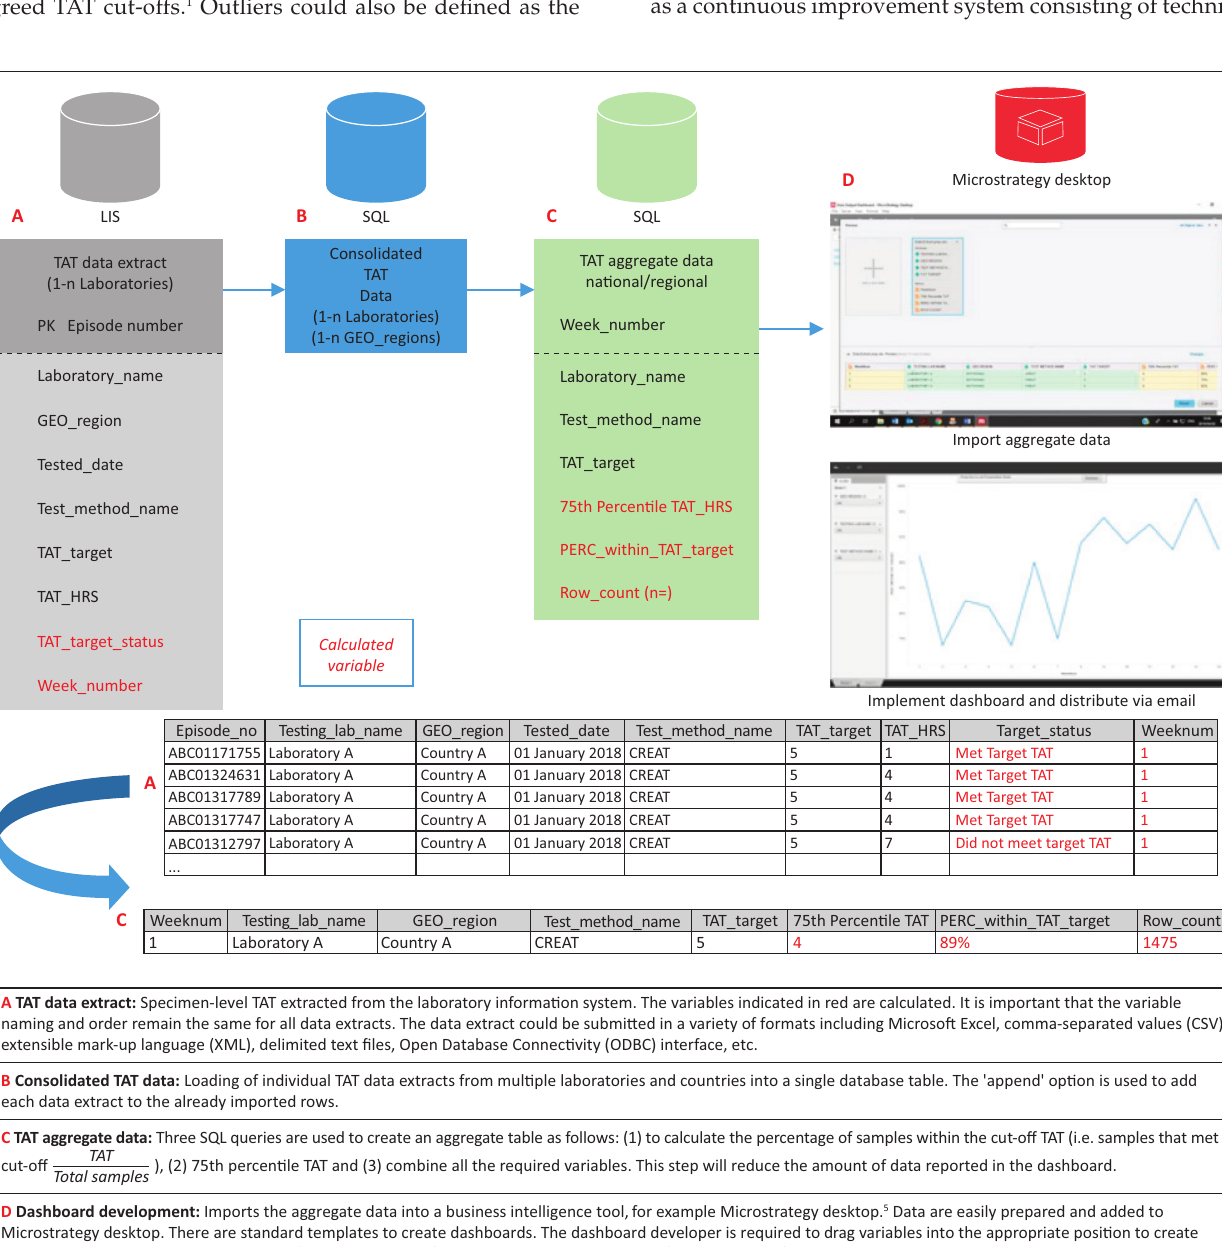
FIGURE 4: Integration of laboratory information system specimen-level turnaround time data from multiple laboratories into a single, aggregated structured query language database for development of an interactive dashboard, Gauteng, South Africa,